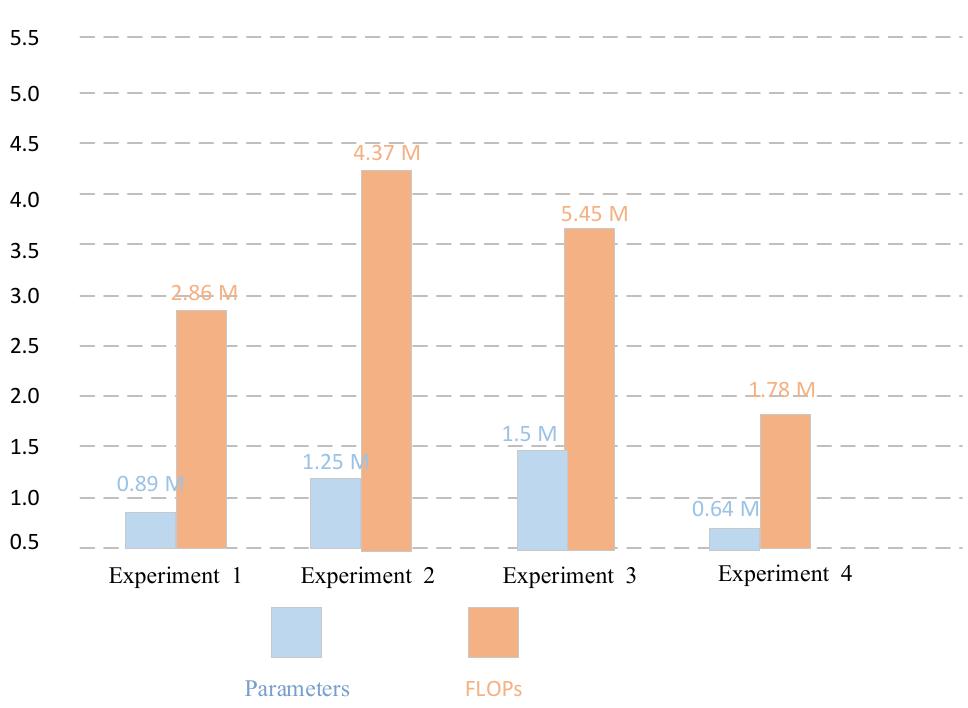
Figure 20. Comparison of parameters and FLOPs values between dimension-wise convolution and traditional convolution on RSSCN dataset with training ratio of 50%.